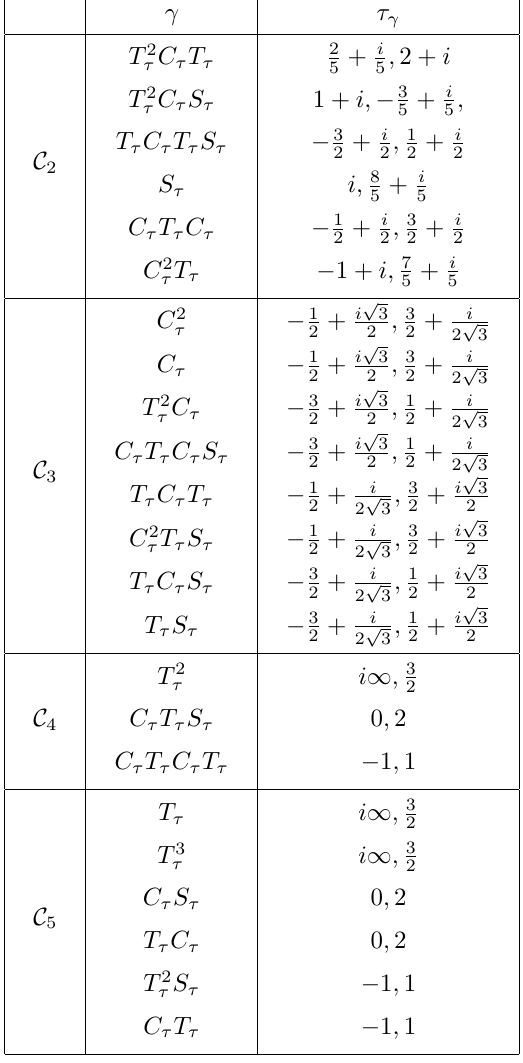
Table 3 . The non-identity elements of Γ 4 and respective